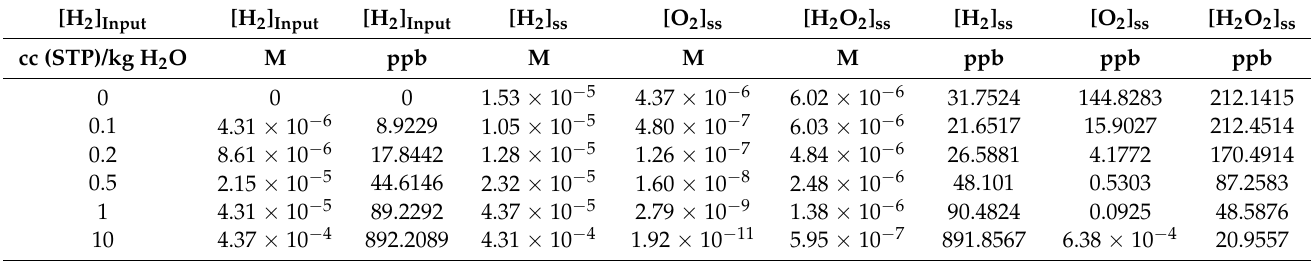
Table 23. Steady-state concentrations of H 2 , O 2 , and H 2 O 2 as a function of the concentration of hydrogen added to the coolant for the simulated environment in an average Equatorial Port module located in the PFA of the IBED